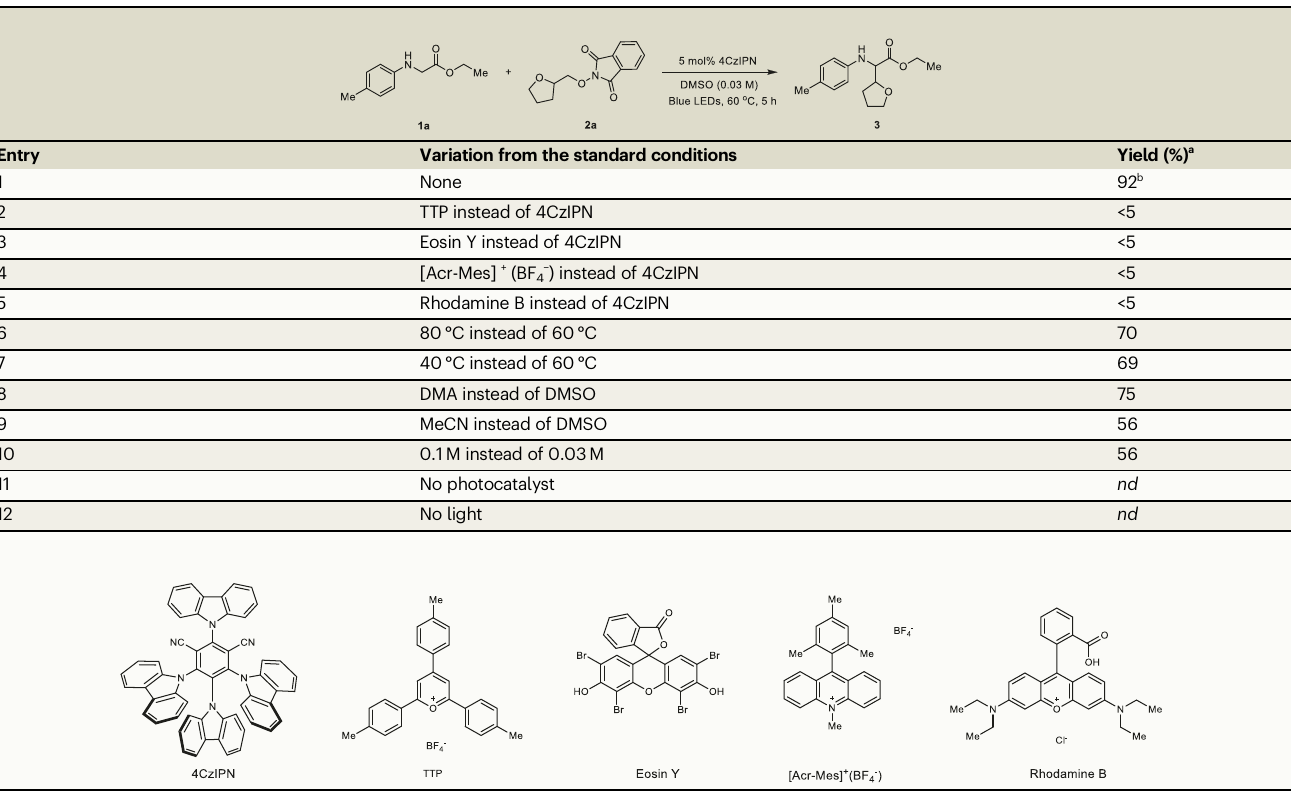
Table 1 | Optimization of the reaction